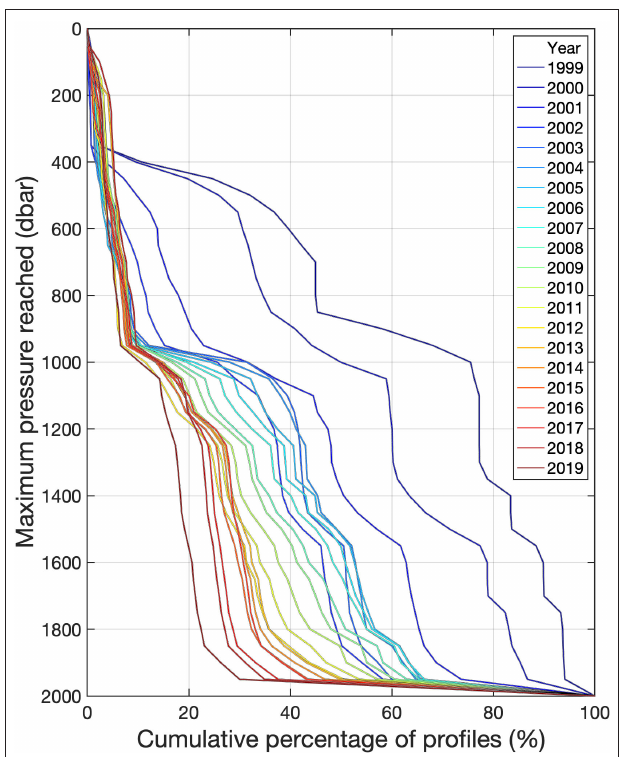
FIGURE 7 | Cumulative percentage of Argo profiles that reached a given pressure (in 50-dbar intervals from 0 to 2,000 dbar) in each year from 1999 to 2019. For example, the percentage of profiles that sampled to at least 1,600 dbar increased from only 10% in 1999 to 80% in